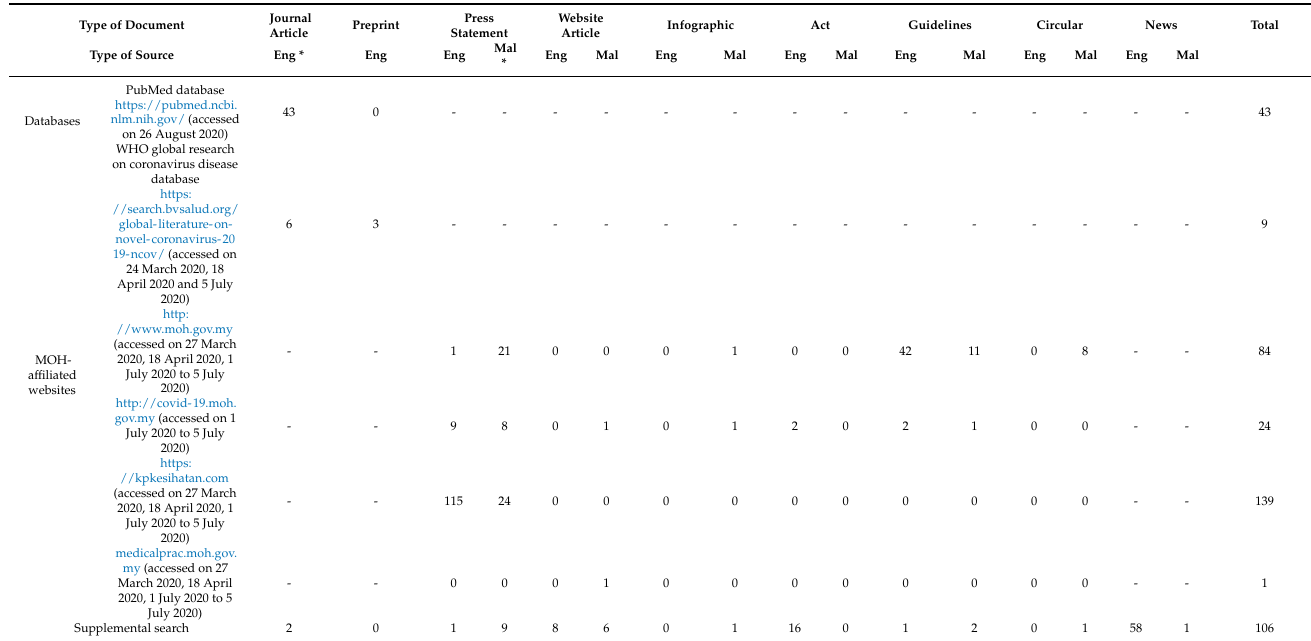
Table A3. Summary of type and number of documents (including duplicates) yielded from database and website